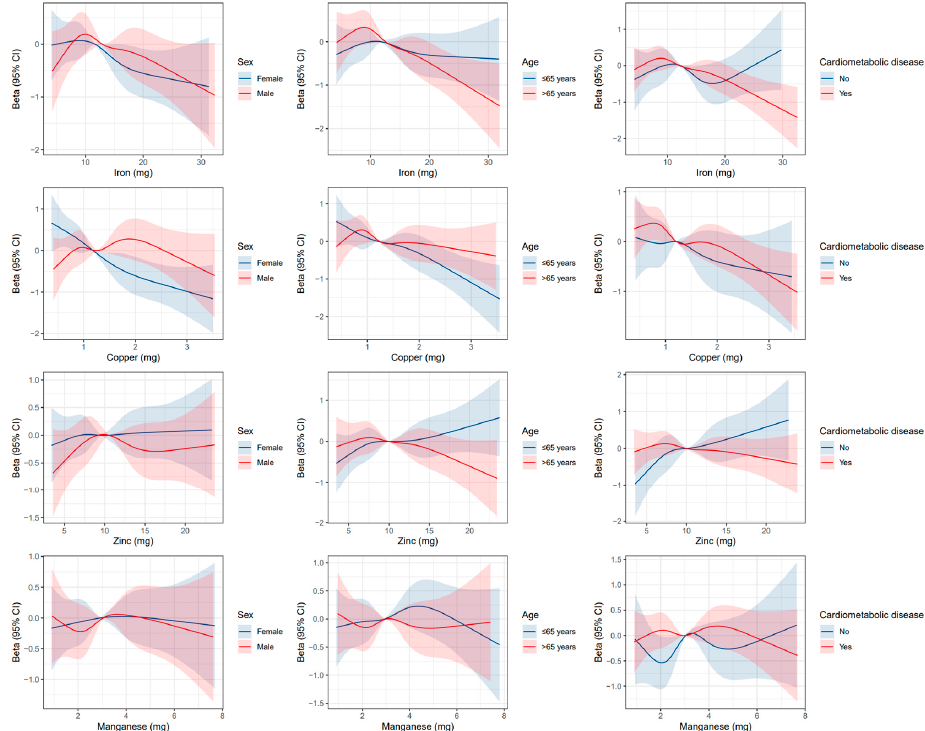
Figure 2. Restricted cubic splines for the association of dietary intake levels of iron, copper, zinc, and manganese with global cognitive score by age, sex, and cardiometabolic disease. The solid line represents the beta of the linear model, and the shaded area represents the 95% CIs of beta.